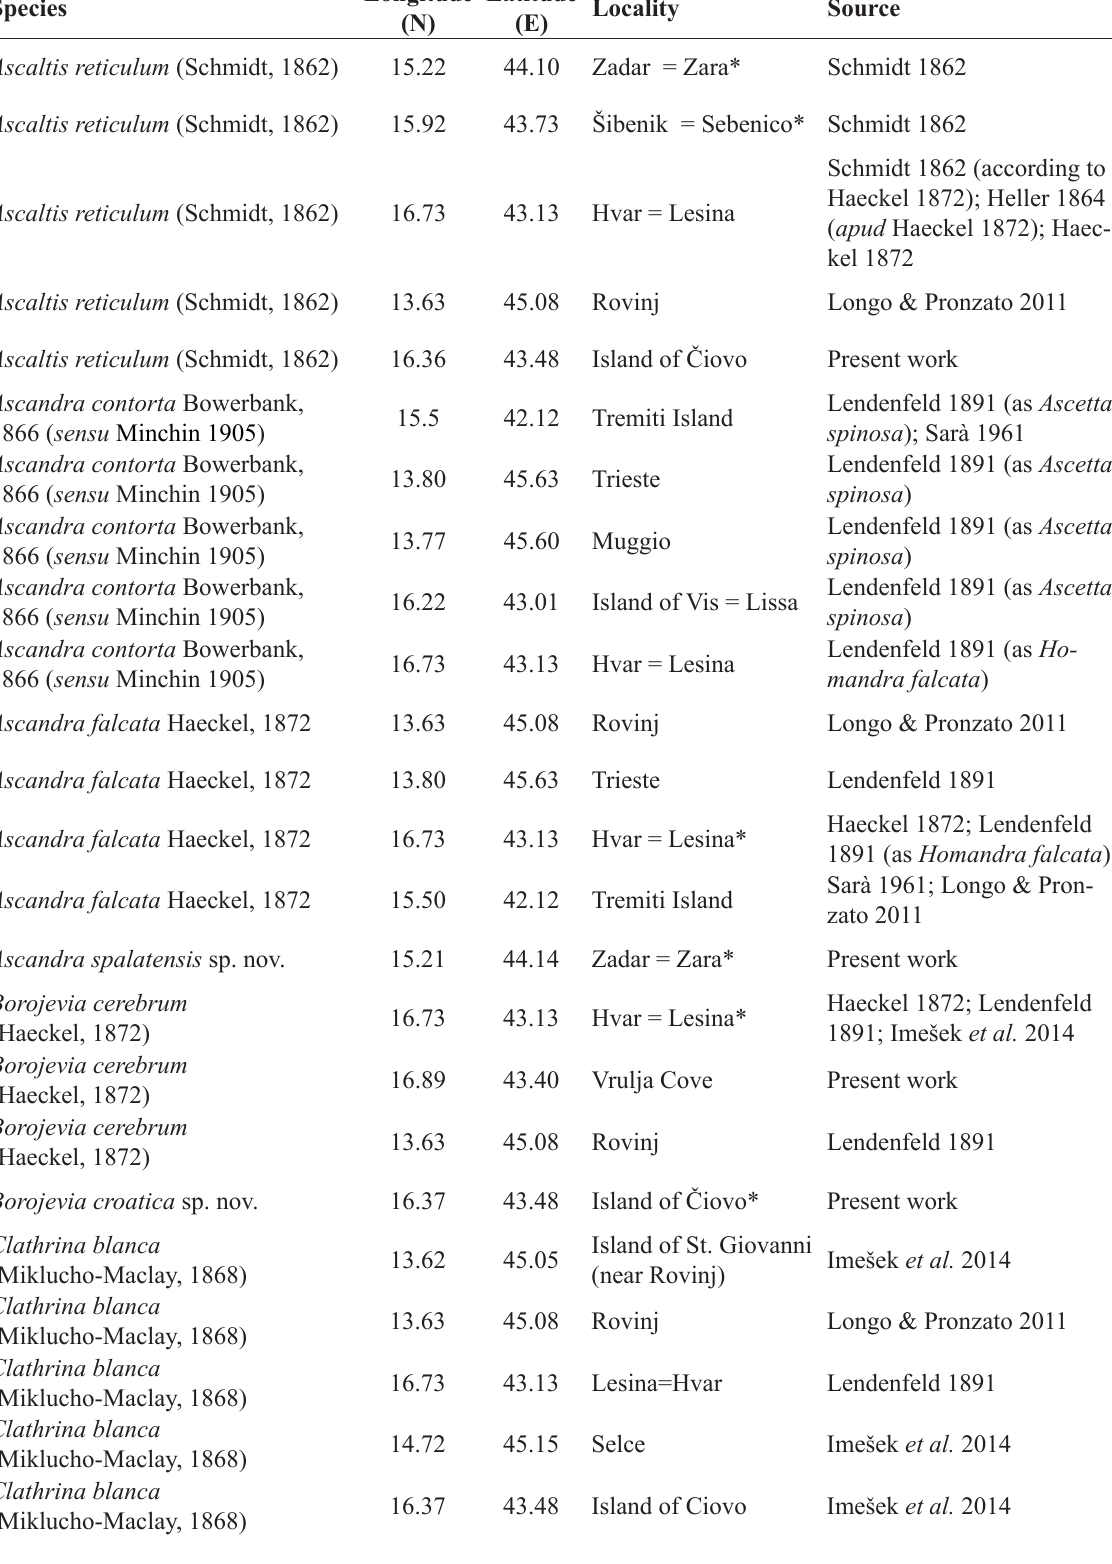
Table 12. Calcinean species reported from the Adriatic Sea and their distribution. *Type locality. ** Probably Clathrina conifera or C. primordialis